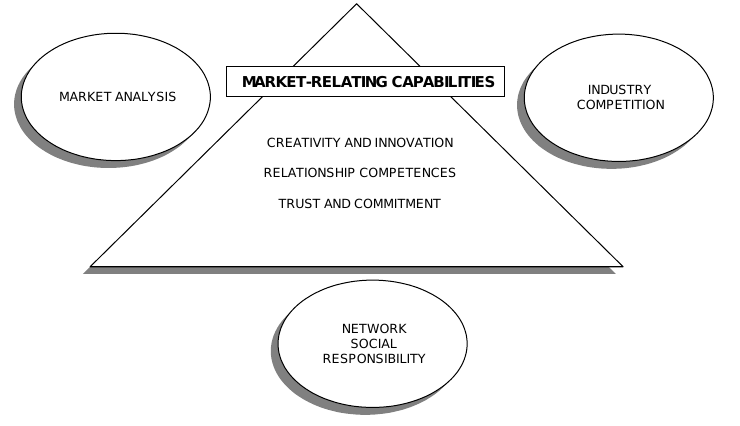
Figure 1 : Market-Driven Management in the Event